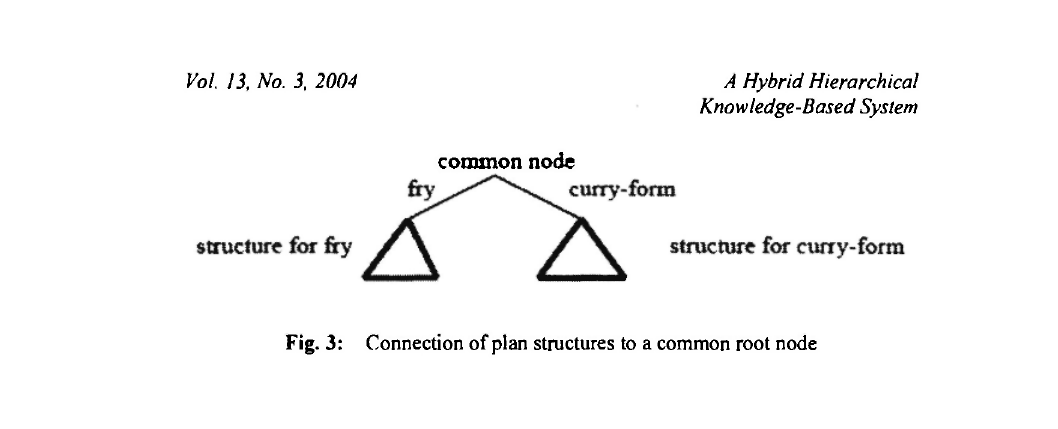
Fig. 3: Connection of plan structures to a common root